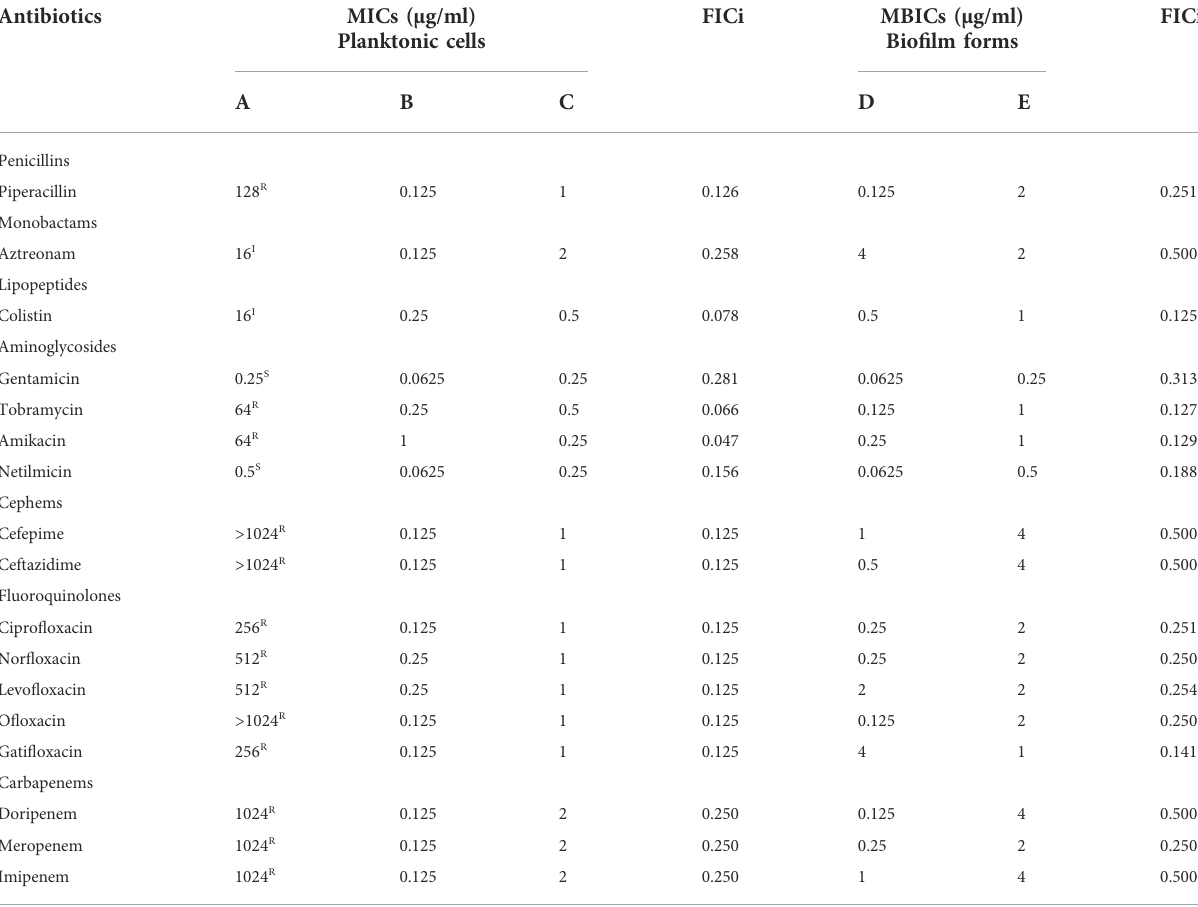
TABLE 2 FICi values of combination of CAAgNPs with antibiotics against planktonic and bio fi lm forms of P. aeruginosa PAW1.